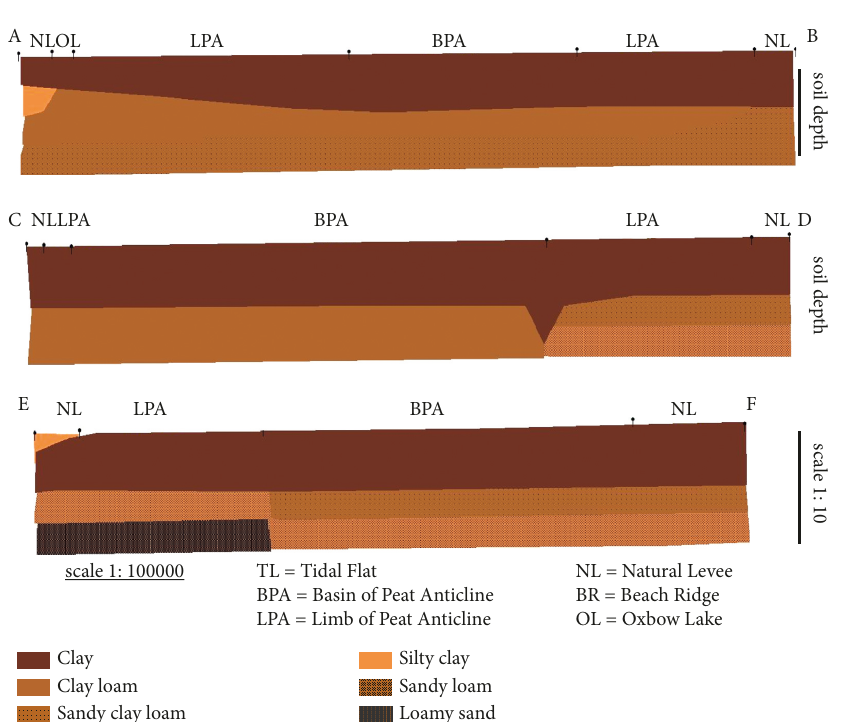
Figure 7: Soil profile for cross-section AB, CD, and EF in Barito Delta. The location of cross-section AB, CD, and EF can be checked in Figure 1. It is constructed based on the result of interpolation of soil fraction applying Bayesian statistics. Horizontal axis is land surface, while soil depth is vertical axis. Horizontal and vertical scales are different for layout configuration